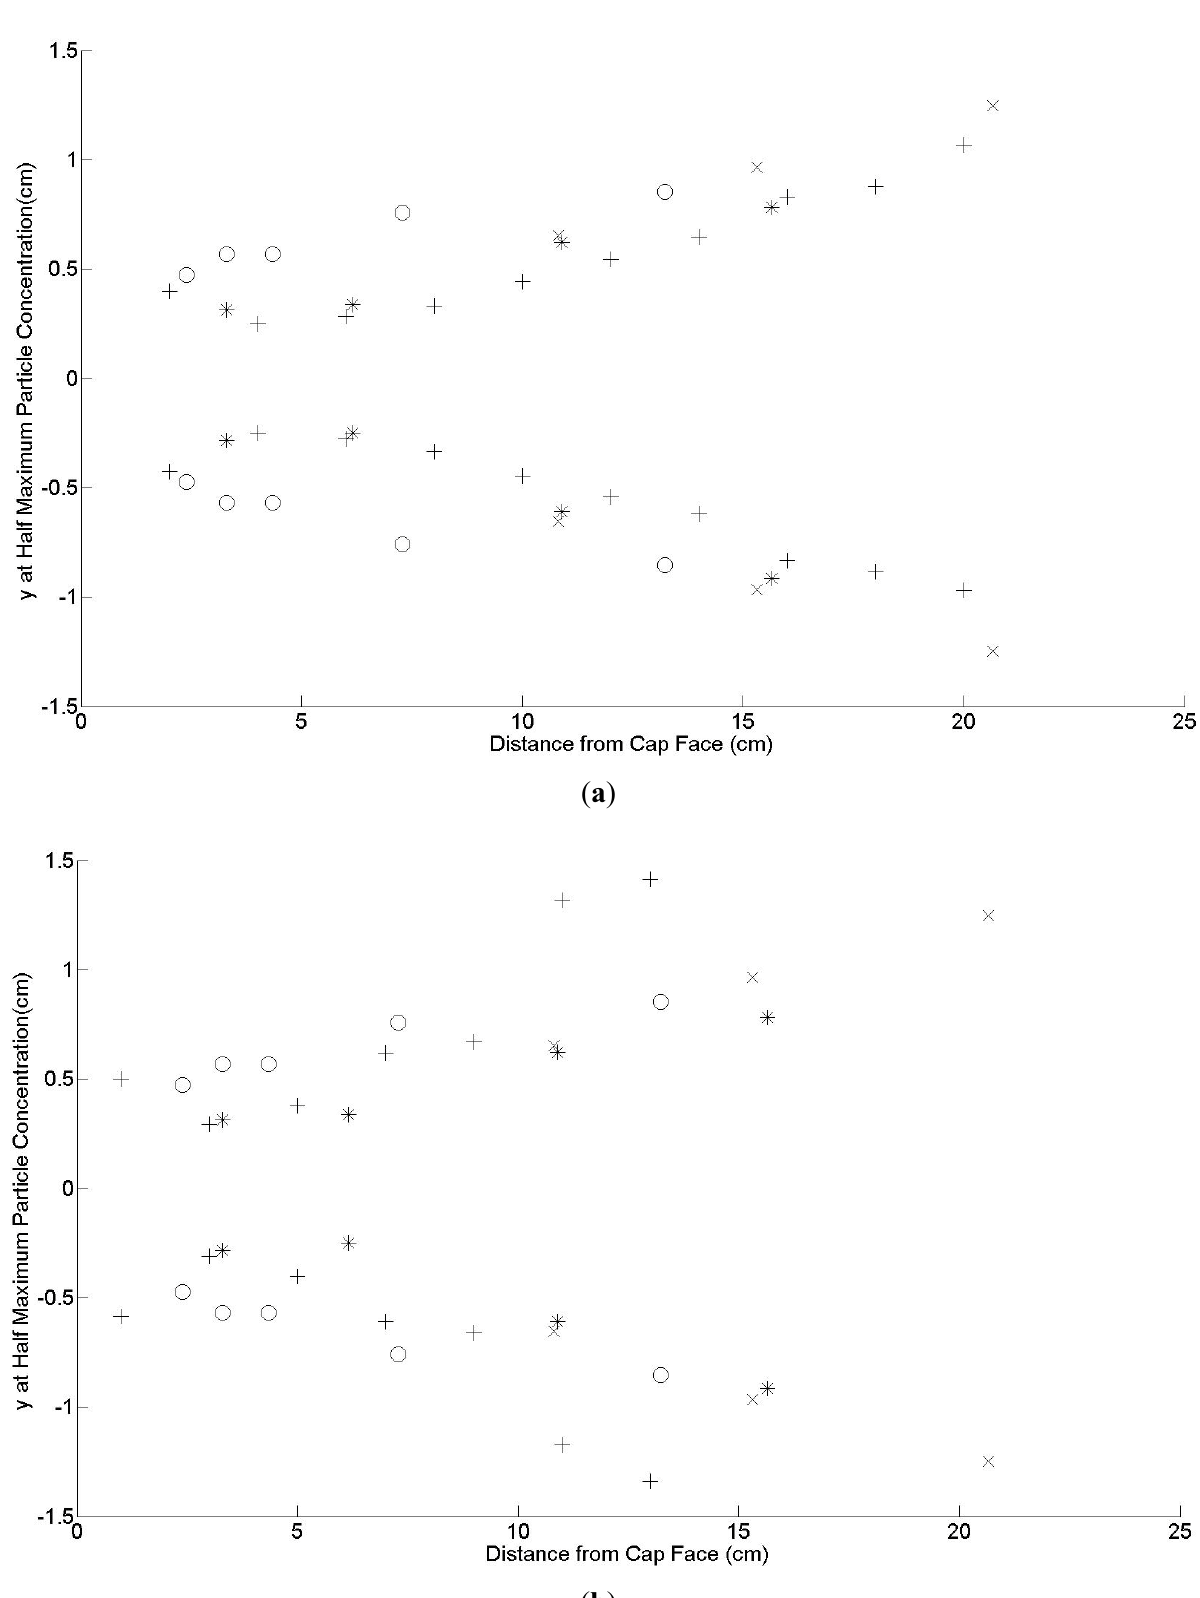
Figure 9. The radius of the particle stream at half maximum concentration and comparison with literature data: “+” present study data; “o” Mostafa et al. [5]; “ × ” Fan et al. [11]; “ ∗ ” Birzer et al. [12] for ( a ) Gun Head 2: Experiment 2 and ( b ) Gun Head